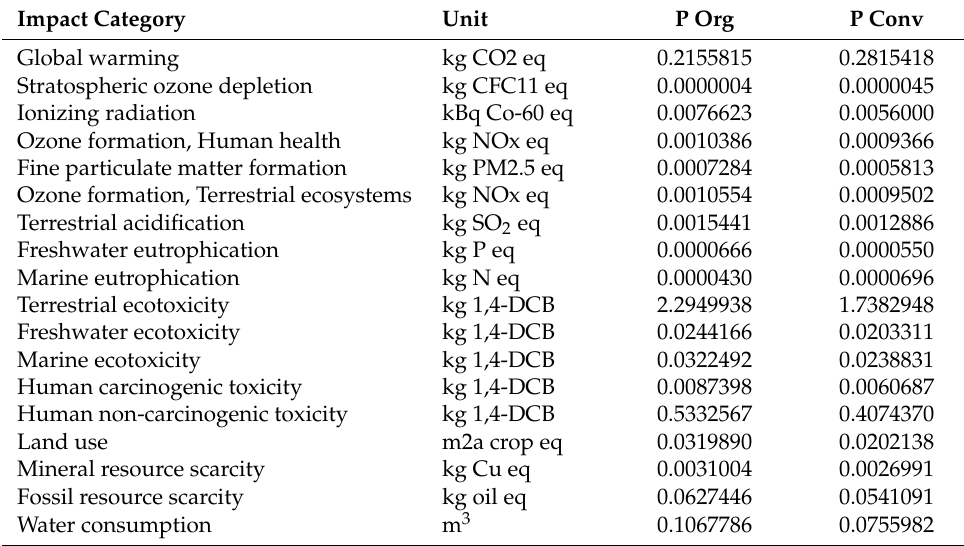
Table 5. Characterization factors and environmental impact per kg of early organic and conventional potatoes